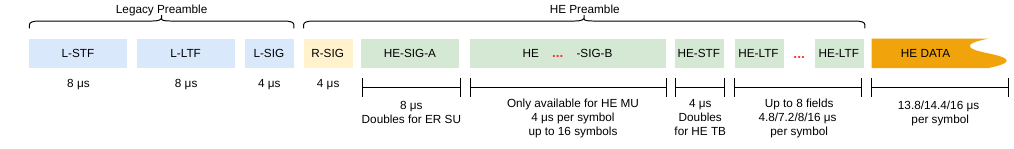
Figure 8. Preamble format in Wi-Fi 6 depends on the frame